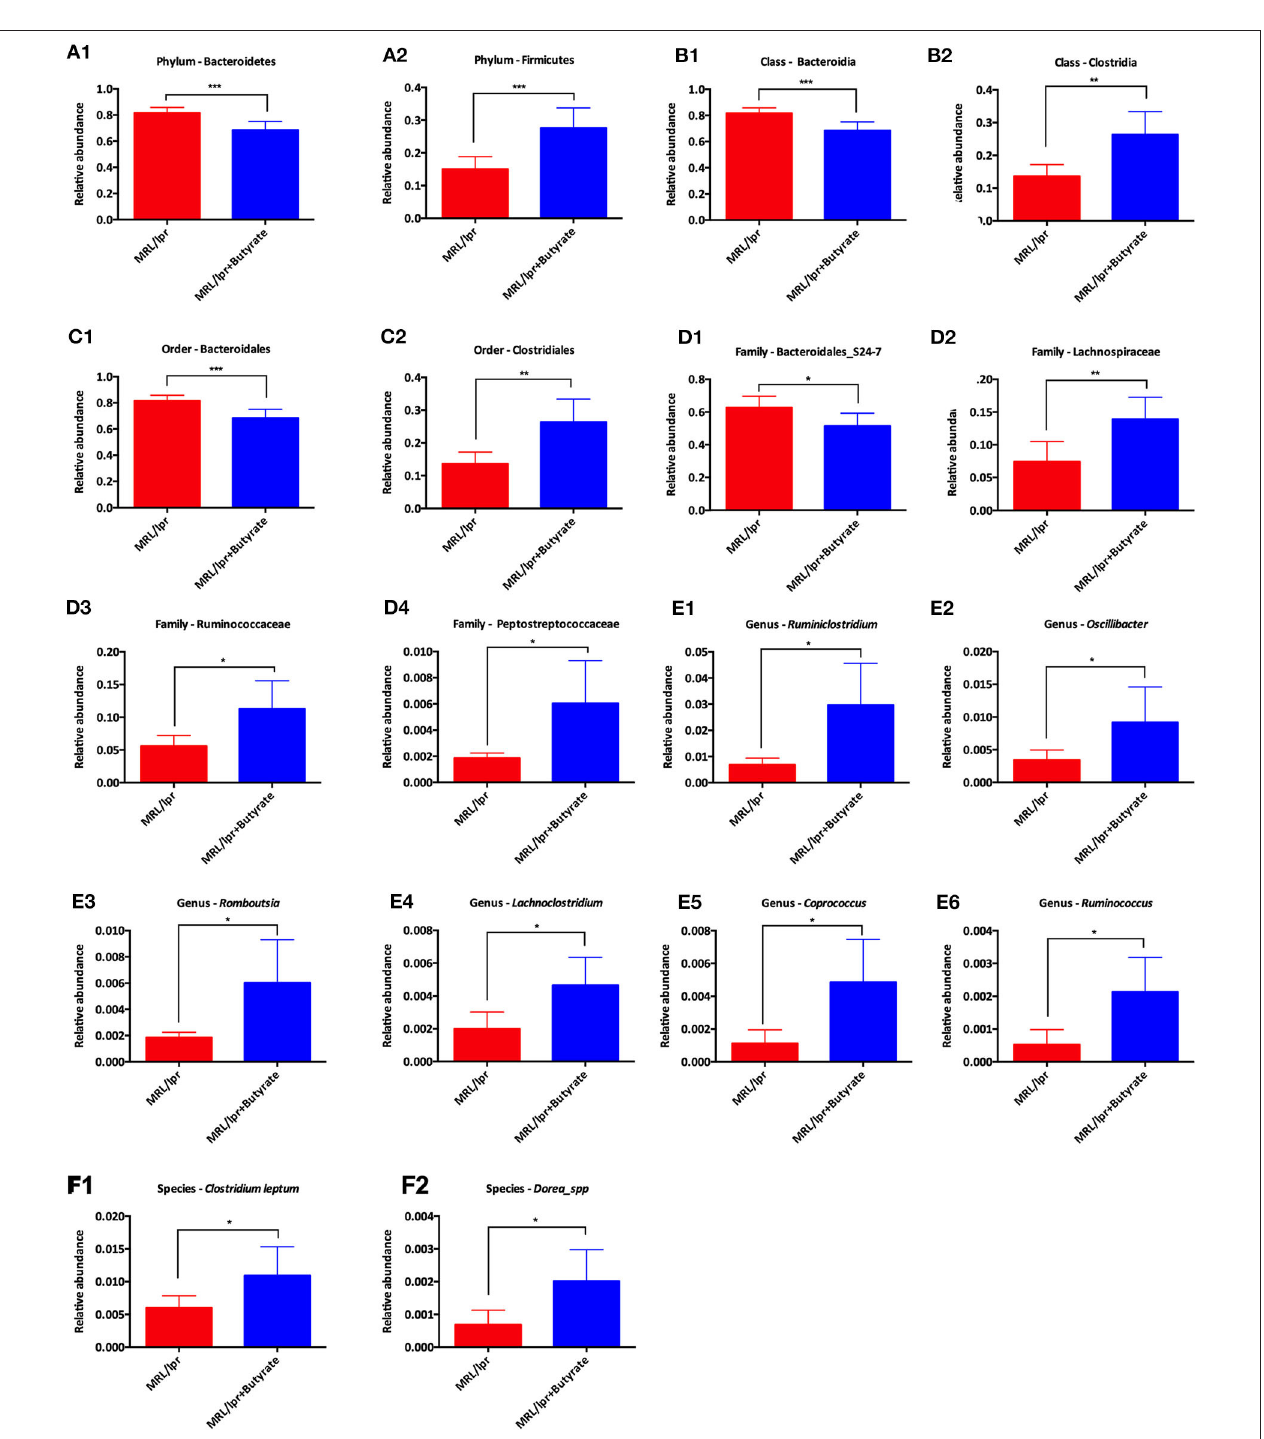
FIGURE 6 | T -test bar plot for analysis of difference in taxa from phylum level to species level between MRL/lpr mice and butyrate-treated MRL/lpr mice. Analysis of taxa differences at the phylum level (A) , at the class level (B) , at the order level (C) , at the family level (D) , at the genus level (E) , and at the species level (F) ; * P < 0.05, ** P < 0.01, *** P <